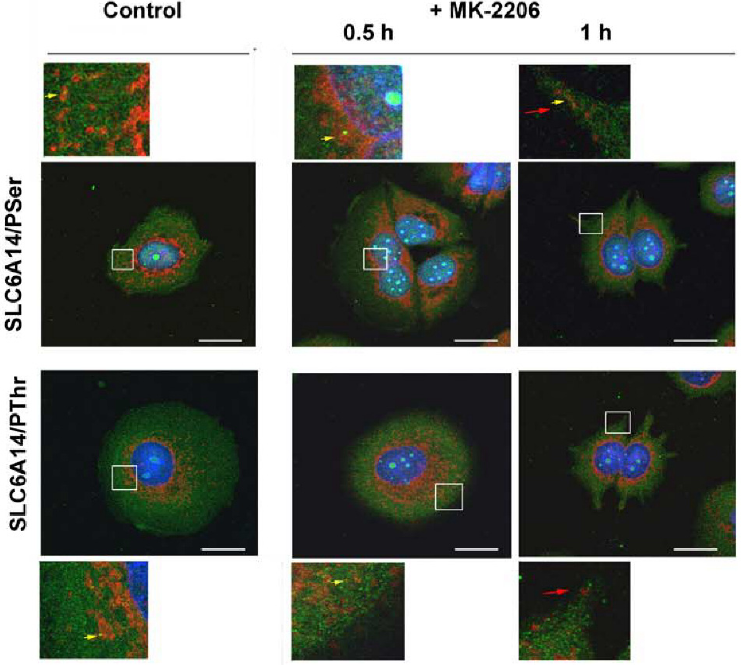
Figure 8. Immunocytochemistry analysis of SLC6A14 phosphorylation in MCF-7 cells. Untreated cells or cells incubated for the indicated time with 5 µ M MK-2206 were fixed and subjected to the immunocytochemistry procedure, as described in Section 2.4. The following primary antibodies were used: rabbit anti-SLC6A14 (1:250, red) with either mouse anti-phosphoserine (1:250, green) or mouse anti-phosphothreonine (1:200, green), as indicated on the left. The selected areas are shown as magnified images either above or below the corresponding panels. The detected co-localizations of transporter and phosphorylated amino acid are indicated with yellow arrows, and the surface presence of SLC6A14 with red arrows. Representative images from 2 independent cell passages subcultured in 3 different cover slips each are shown. The selected images come from the same passage. Bar: 20 µ m.